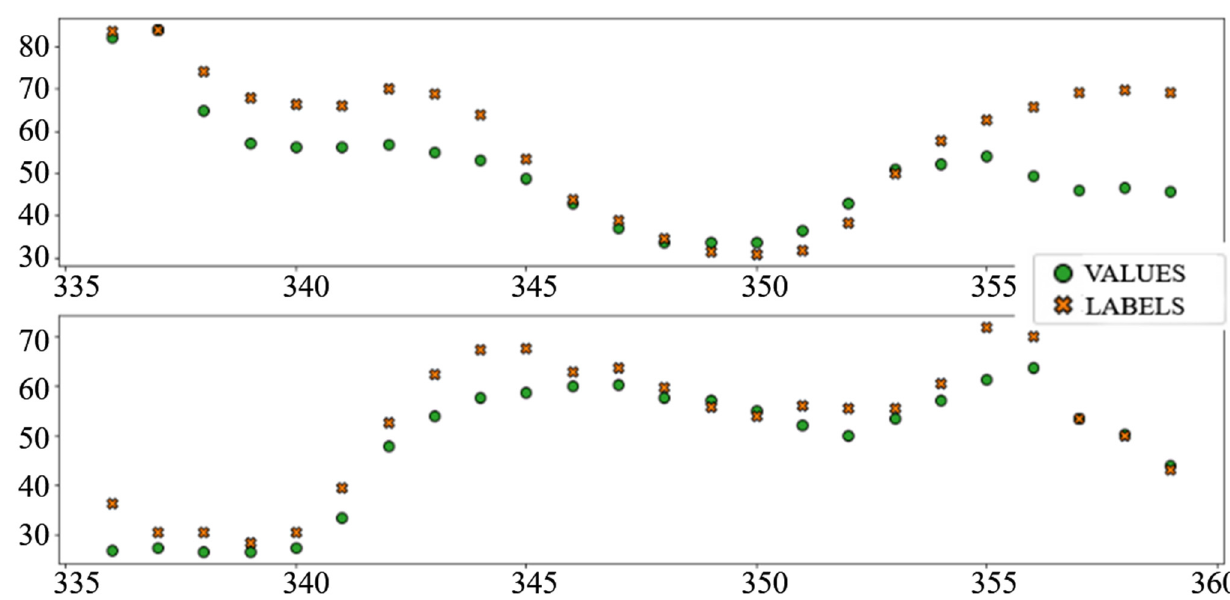
Figure 10. Price prediction examples: “Dense”.